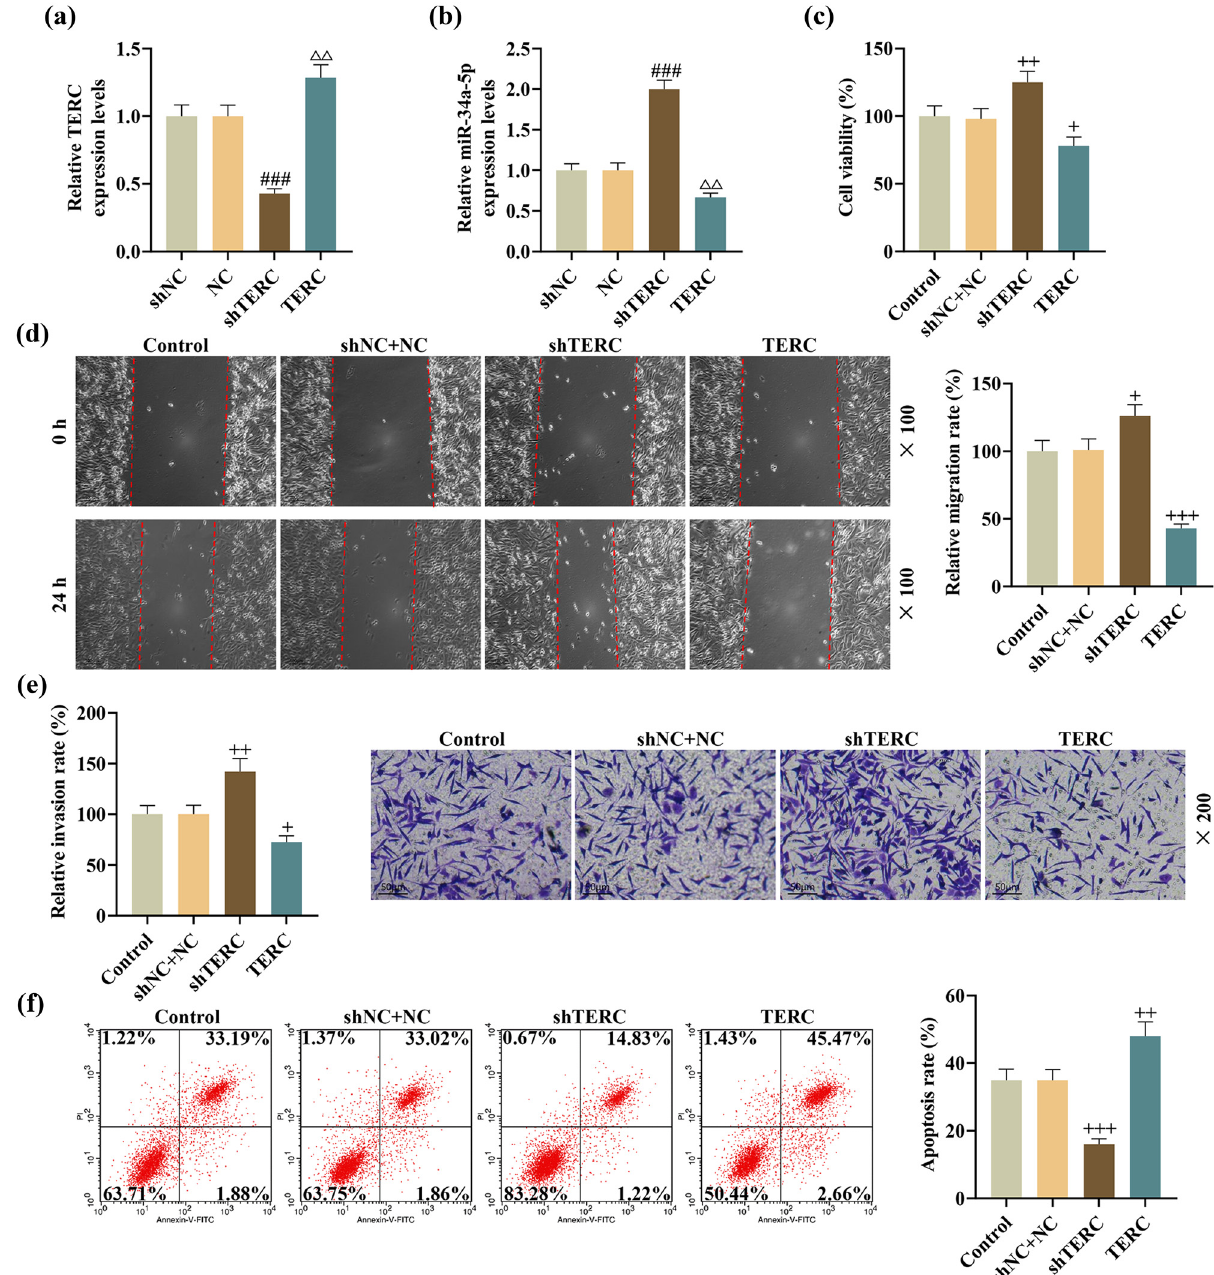
Figure 3: TERC regulated the viability, migration, invasion, and apoptosis of LPS - induced PC - 12 cells. ( a and b ) The expressions of TERC and miR - 34a - 5p in shTERC/TERC overexpression plasmid - transfected PC - 12 cells after LPS treatment were analyzed by qRT - PCR. ( c ) The viability of shTERC/TERC overexpression plasmid - transfected PC - 12 cells after LPS treatment was measured by CCK - 8 assay. ( d ) The migratory ability of shTERC/TERC overexpression plasmid - transfected PC - 12 cells after LPS treatment was evaluated by wound healing assay ( magni fi cation: × 100; scale: 100 µm ) . ( e ) The invasive ability of shTERC/TERC overexpression plasmid - transfected PC - 12 cells after LPS treatment was assessed by Transwell assay ( magni fi cation: × 200; scale: 50 µm ) . ( f ) The apoptosis of shTERC/TERC overexpression plasmid - transfected PC - 12 cells after LPS treatment was detected by fl ow cytometry. + P < 0.05, ΔΔ P or ++ P < 0.01, ### P or +++ P < 0.001; # vs shNC; Δ vs NC; + vs shNC +